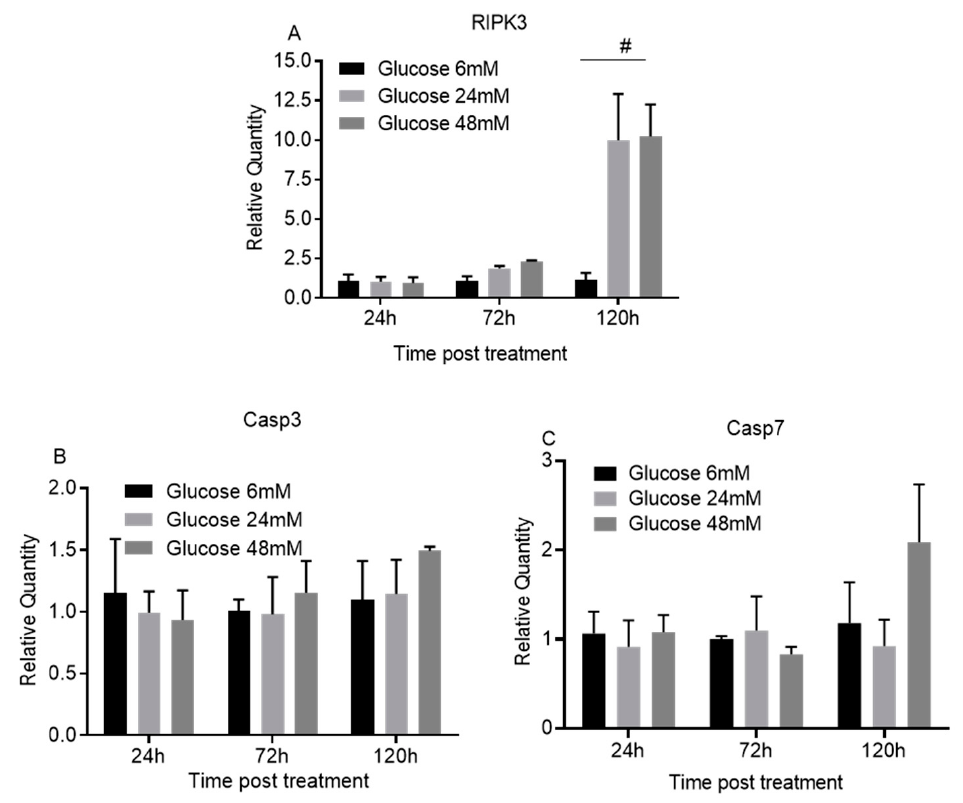
Figure 4. High glucose upregulates necrosis but not late apoptosis related genes in oral keratinocytes. TIGK cells treated with different concentrations of glucose (6, 24, and 48 mM) were harvested. Total RNA was extracted and cDNA was prepared. Real time PCR was performed to detect the mRNA expression of RIPK3 ( A ), Caspase 3 ( B ), and Caspase 7 ( C ). There were 3 replicates for each culture condition and time point. The expression of the targets in the cells with 6 mM glucose treatment at each time point was used as the baseline. # p < 0.01. One-way ANOVA followed by Tukey’s post-tests was used for statistical analysis.